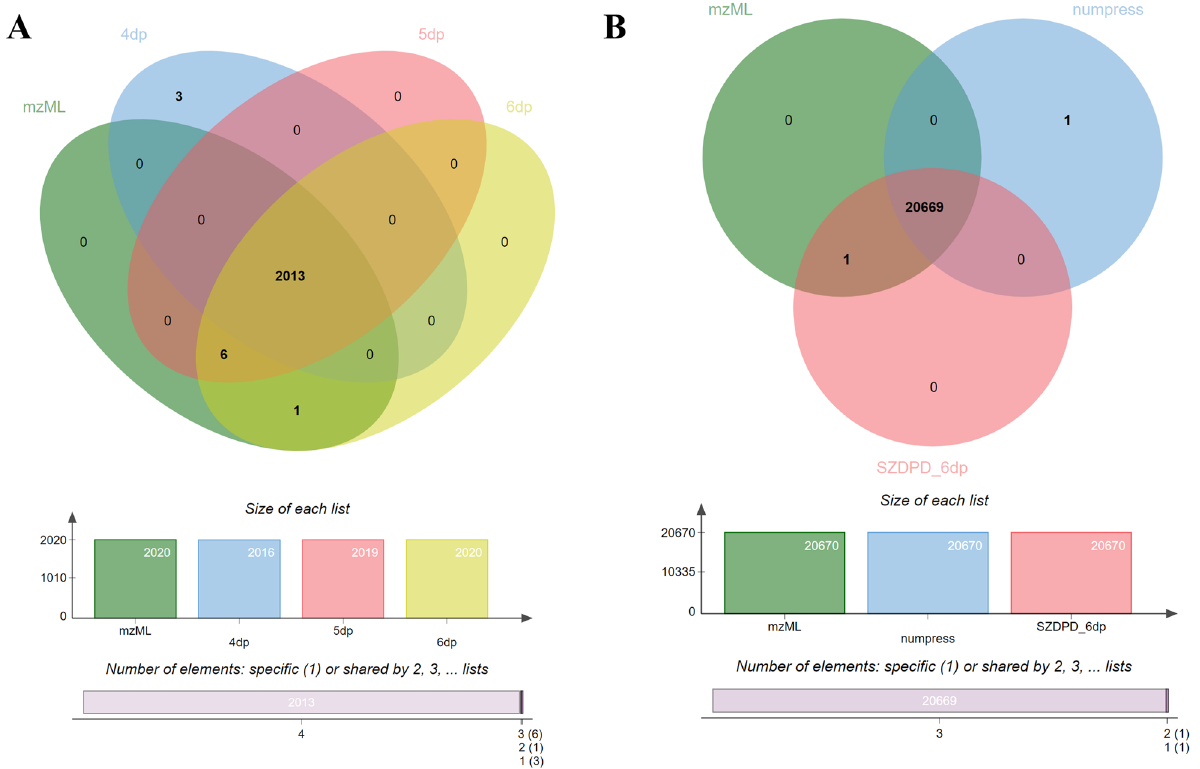
Figure 5. ( A ) Peak number comparison of mzML file and Aird (4, 5, 6 decimal points stored) files, after ADAP chromatogram building in MZmine3. Vendor file 7 is used. ( B ) Peak number comparison of mzML, Numpress and Aird (6 decimal points stored), after ADAP chromatogram building in MZmine3. Vendor file 13 is